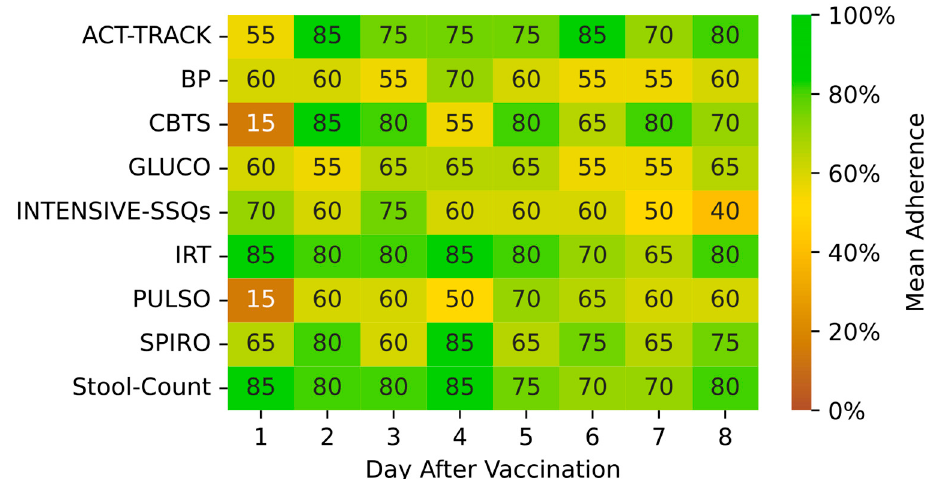
Figure 4. Adherence to monitoring modalities heatmap for both monitoring periods combined (the 1st and 2nd vaccination) for the whole study population. Green ‐ color fields indicate very high ad ‐ herence, yellow fields indicate moderate adherence and brown fields indicate low adherence. On the x ‐ axis, the days after vaccination are presented for intensive monitoring phase, i.e., the first 8 days, while the y ‐ axis corresponds to modalities. Adherence to INTENSIVE ‐ SSQs means that all